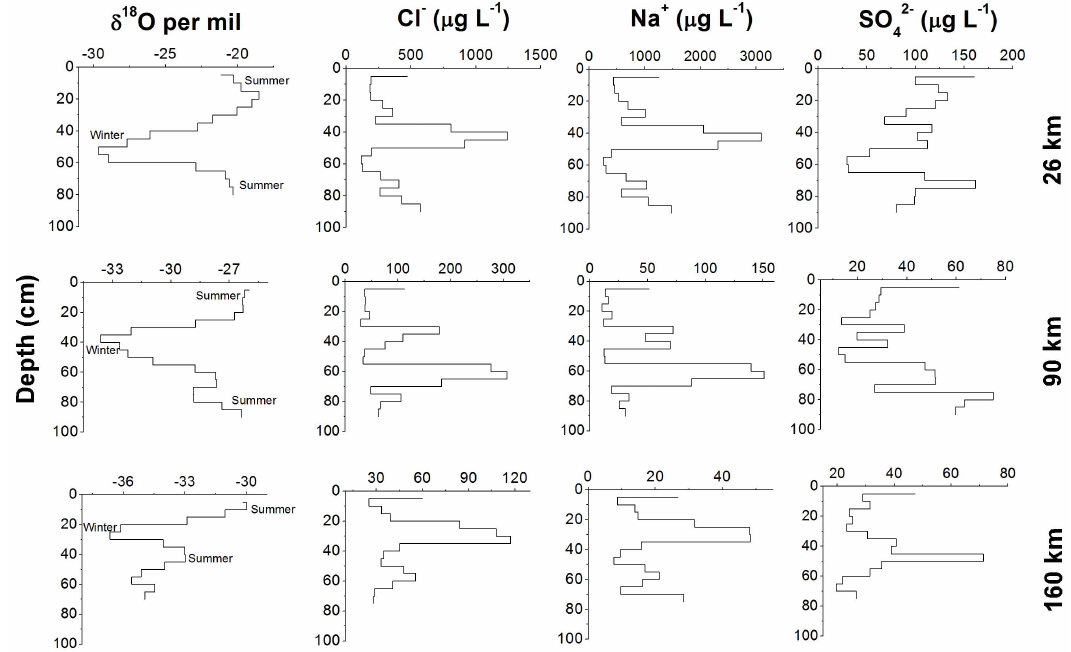
Fig. 2. Temporal records of δ 18 O, Cl − , Na + and SO 2 − from sites representing coast (26km), mid-way (90km) and the interior (160km) 4 in Princess Elizabeth Land. Seasonality in δ 18 O variability was primarily used to determine the annual accumulations within the core, supported by Na + , Cl − and SO 2 − 4